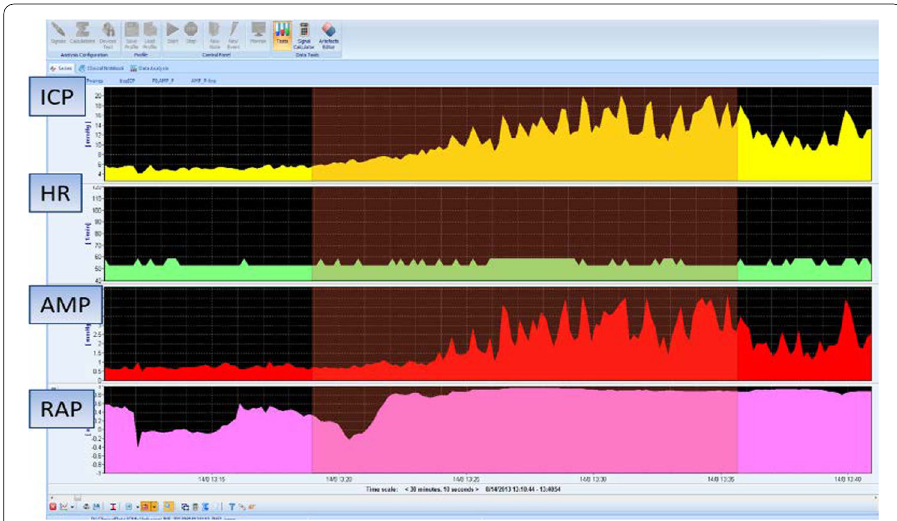
Fig. 3 Example of a constant rate infusion test in a post-SAH patient with HCP. HCP with normal baseline ICP. The dark red area depicts infusion period. Although baseline ICP was normal (4.75 mmHg), it rises until 36.5 mmHg until the end of the infusion study (plateau pressure), whereas the R to CSF outflow (Rcsf) is increased (18.59